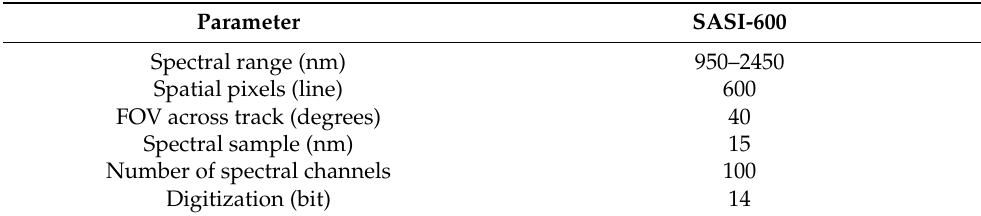
Table 1. Technical specifications of the acquired airborne hyperspectral